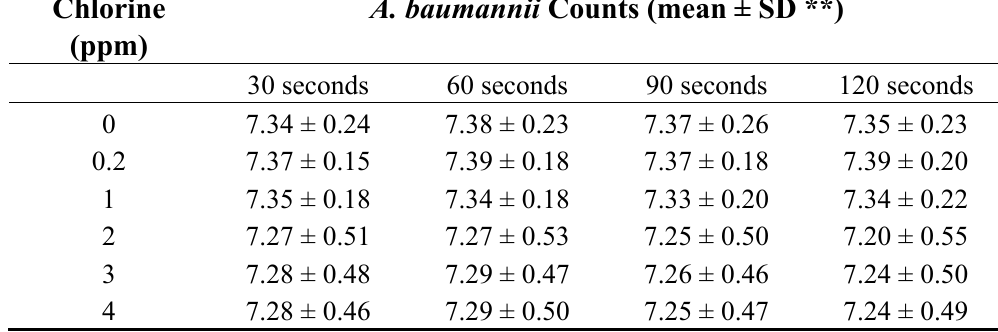
Table 2. Effect of different concentrations of chlorine on the survival of A. baumannii in deionized water *.